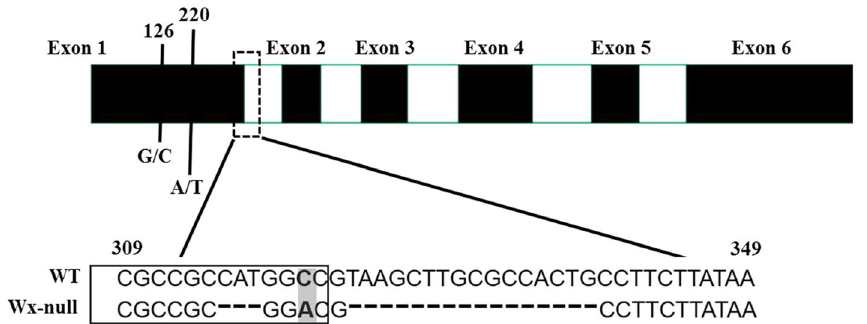
Figure 3. Analysis of Wx-A1 gene sequences in wild-type and Wx-null line. Black and white boxes respectively indicate exons and introns. Numbers show base position. DNA sequences at the border of the first exon are boxed. SNP is indicated by the shaded area. Dashed line indicates the InDel.